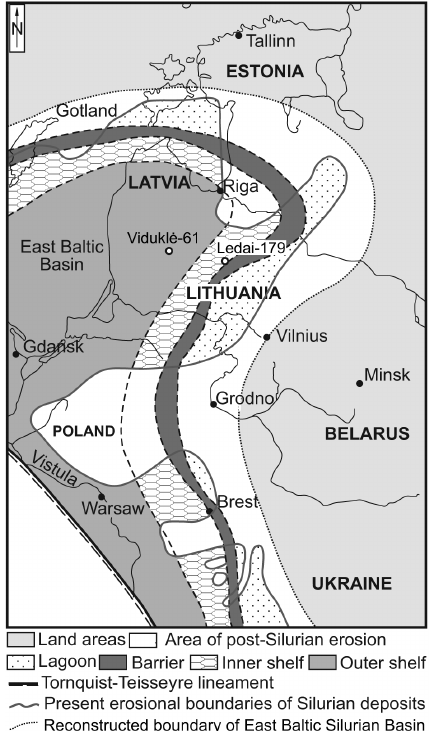
Fig. 1. Facies map of the western margin of the East European Platform (Por ę bska et al. 2004) and locations of